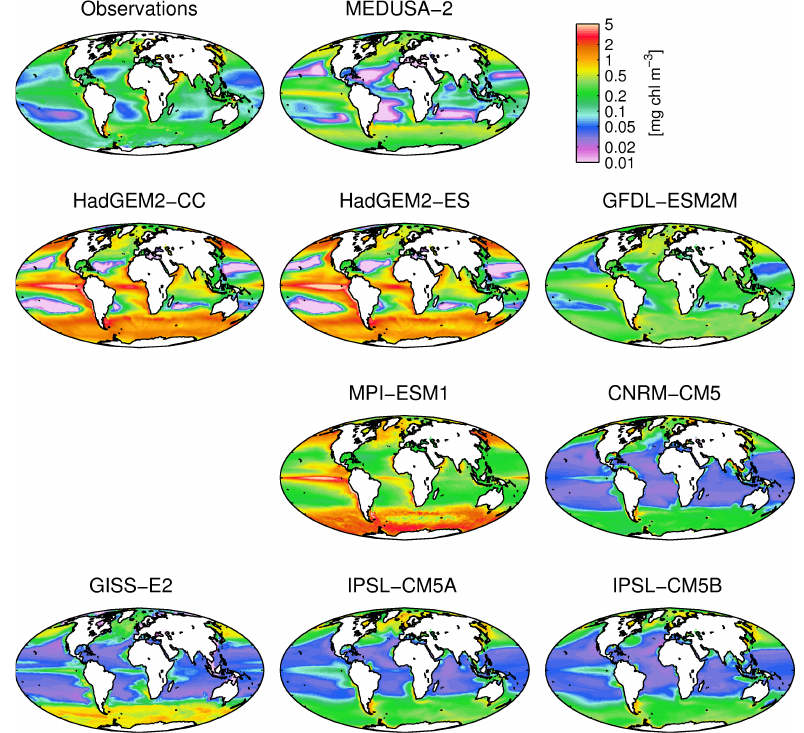
Fig. 44. Intercomparison of annual mean surface chlorophyll for M EDUSA -2.0 and a range of comparable CMIP5 models. Chlorophyll concentration in mgchlm − 3 and is shown on a logarithmic scale.